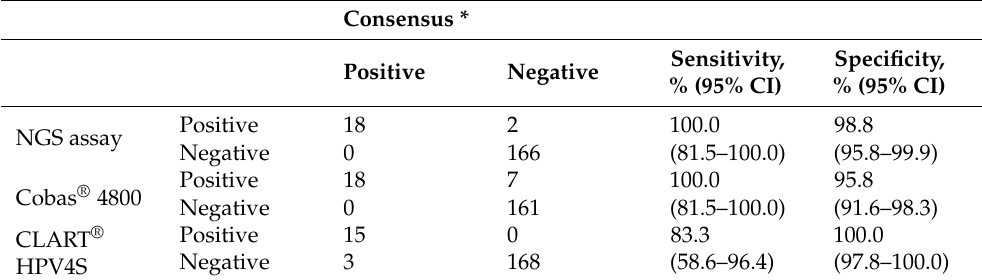
Table 4. Sensitivity and specificity for detection of HPV16 in the NGS assay, Cobas ® 4800, and CLART ® HPV4S assay on GP-collected cervical samples and cervico-vaginal self-samples 1 using a consensus * as